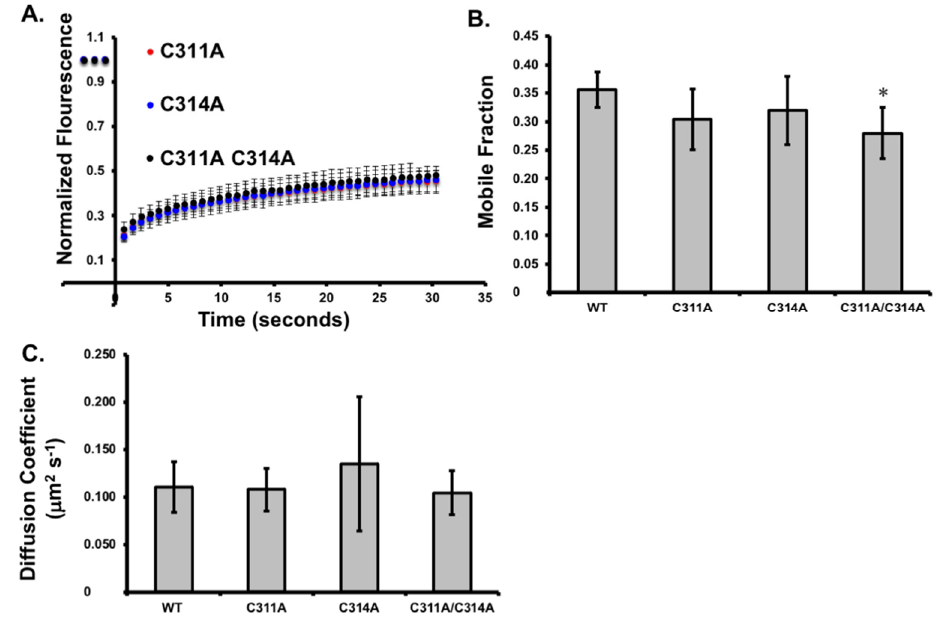
Figure 4. VP40 dynamics at the plasma membrane. ( A ) Fluorescence recovery after photobleaching (FRAP) plot of EGFP-VP40-WT and mutants in COS-7 cells. ( B ) The mobile fraction of EGFP-VP40-WT and mutants in COS-7 cells. ( C ) The diffusion coefficient of EGFP-VP40-WT and mutants was determined and plotted. Values represent the average value over at least three independent experiments and error bars represent ± standard error of the mean. Significance is marked with a *, determined as a p value of 0.05 or less.